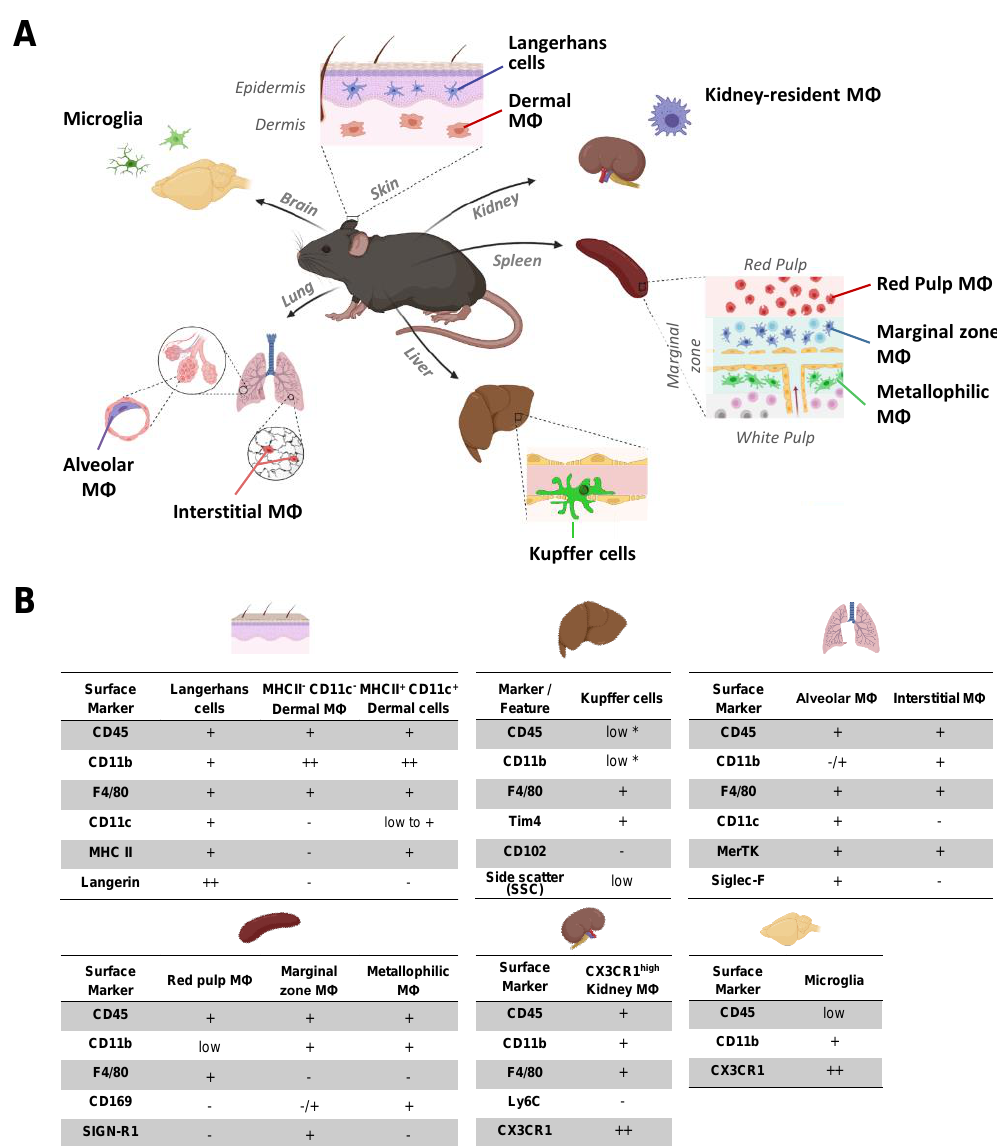
Figure 1. Markers allowing to identify tissue-resident macrophages subsets. ( A ) Schematic representation of the organs and organ-specific tissue-resident macrophages analyzed in this work, i.e., microglia from the brain; Langerhans cells from the epidermis and dermal macrophages from the dermis of the skin; kidney-resident macrophages, red pulp macrophages, the marginal zone and metallophilic macrophages from the spleen; Kupffer cells from the liver, alveolar macrophages from bronchoalveolar lavage and interstitial macrophages from tissue of the lung. ( B ) Depicted are the cell surface markers and cellular features of tissue-resident macrophages that were used for the identification of the respective macrophage